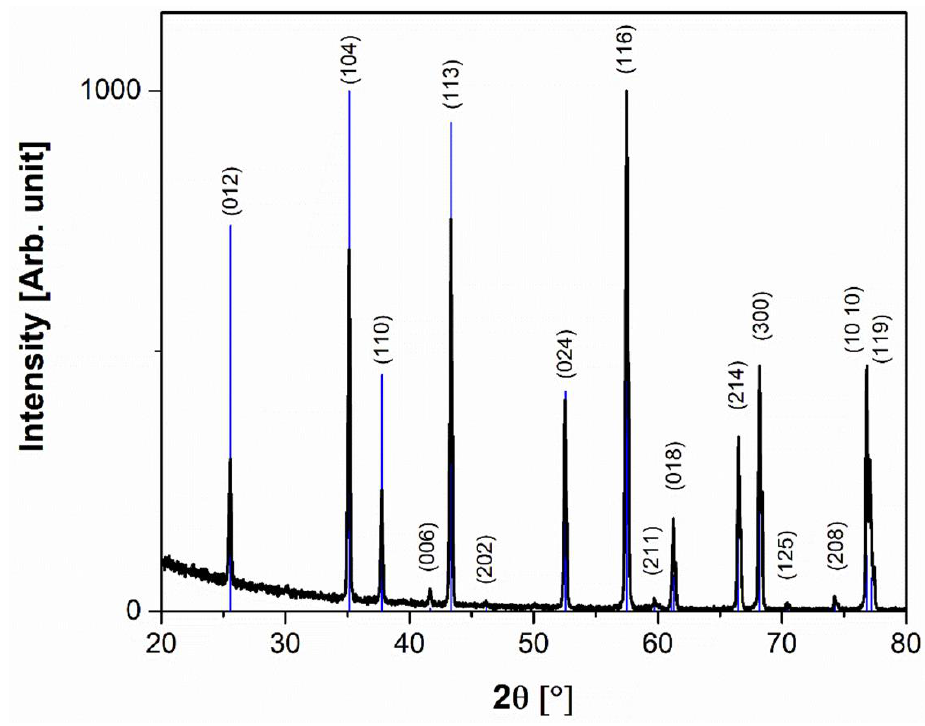
Figure 4. XRD pattern of 3D-printed sintered Al 2 O